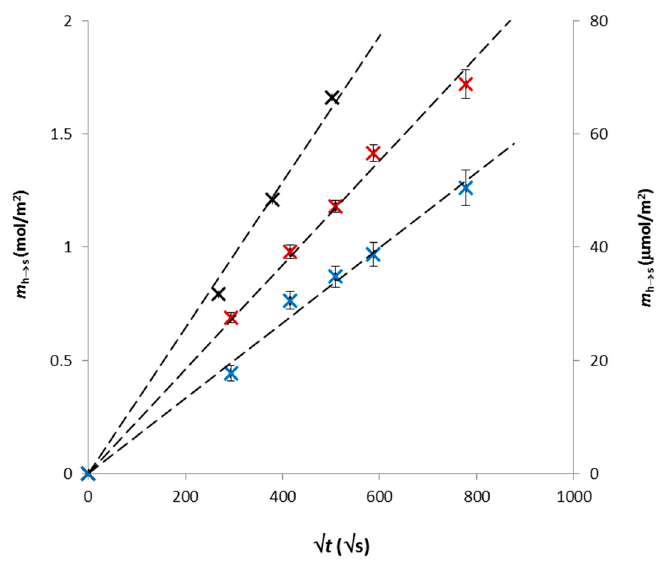
Figure 1. Experimental data obtained for Cu ( black ), MB ( blue ) and RH ( red ) fitted by Equation (1). The highest values of effective diffusion coefficients were determined for pure AG hydrogel.